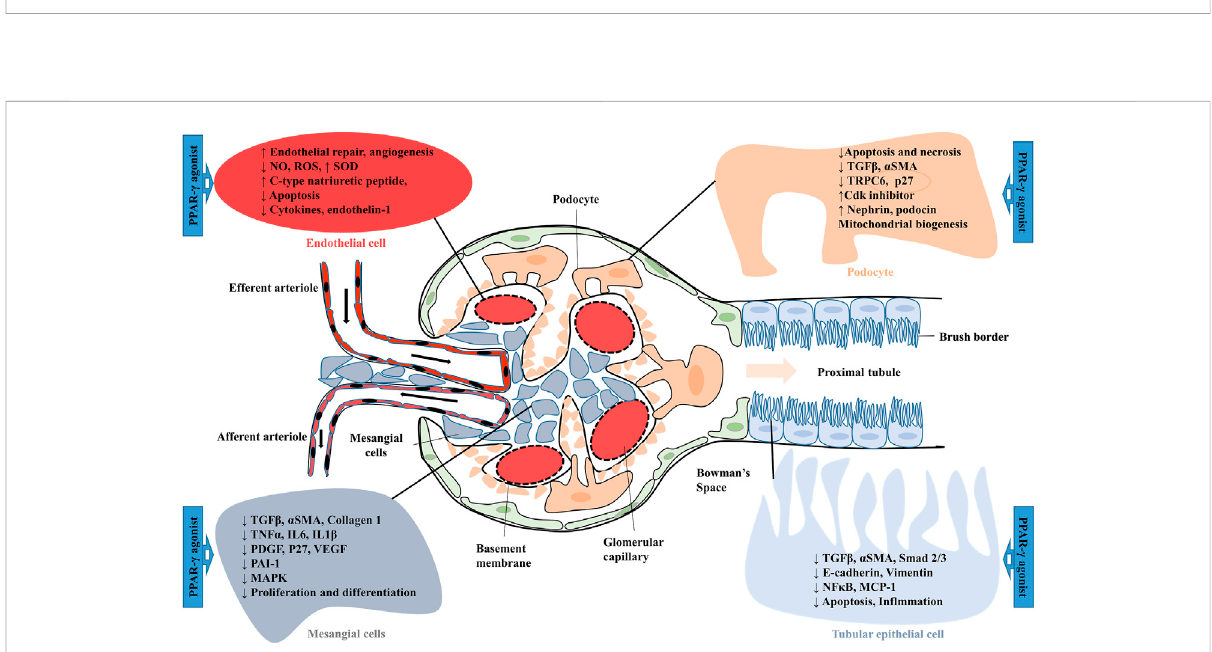
FIGURE 4 Effect of PPAR- γ agonist on the expression of various factors in glomerular and proximal tubular epithelial cells. MCP 1, Monocyte chemoattractantprotein-1;MAPK,mitogen-activatedproteinkinase;NO,Nitricoxide;NF κ B,Nuclearfactor-kappaB;PDGF,Platelet-derivedgrowth factor; PAI-1, Plasminogen activator inhibitor-1; ROS, Reactive oxygen species; Smad 2/3, Small mothers against decapentaplegic 2/3; α SMA, Smooth muscle alpha-actin; SOD, Superoxide dismutase; TRPC6, Transient receptor potential cation channel, subfamily C, member 6; TGF β , Transforming growth factor-beta; VEGF, Vascular endothelial growth